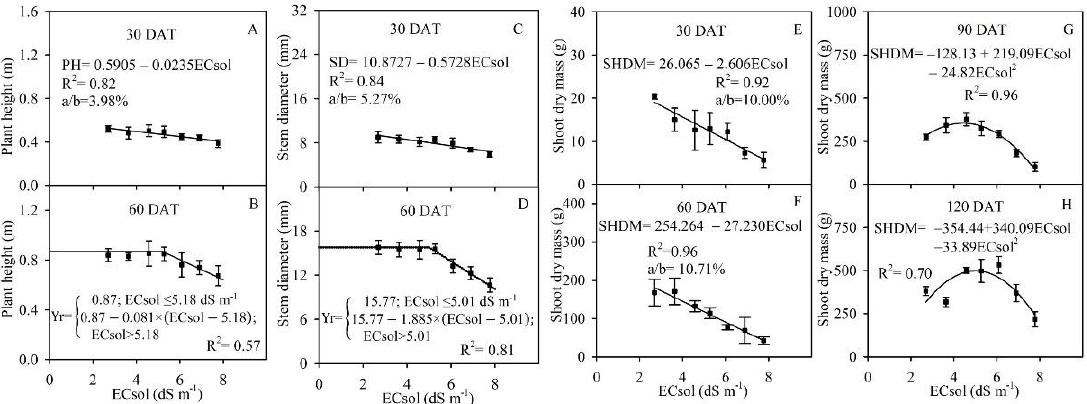
Figure 2. Mean plant height ( A , B ) and stem diameter ( C , D ) at 30 and 60 days after transplanting (DAT), respectively, and shoot dry mass per plant at 30 ( E ), 60 ( F ), 90 ( G ), and 120 DAT ( H ) of “ Biquinho ” pepper cultivated in the hydroponic system as a function of the electrical conductivity of the nutrient solution (ECsol).